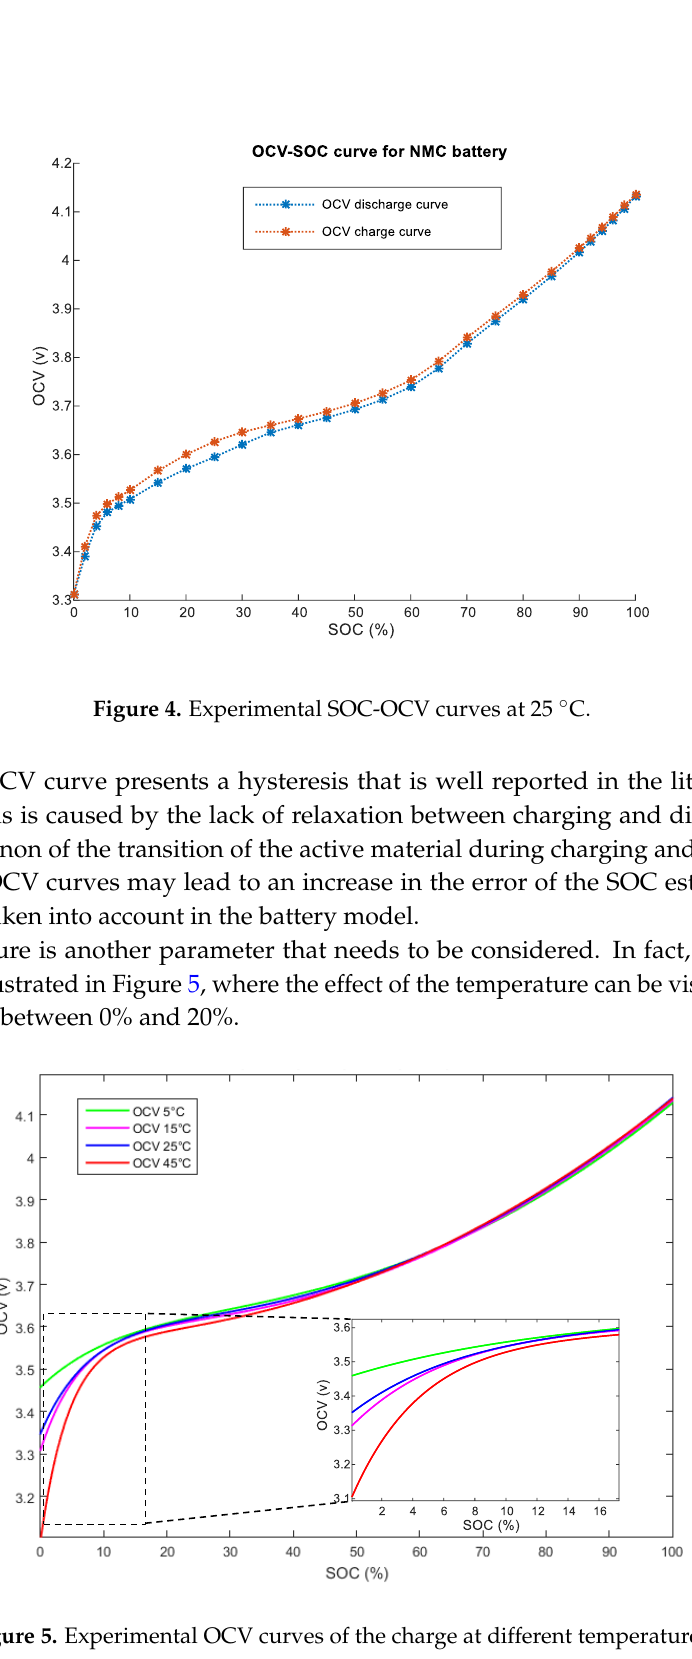
Figure 5. Experimental OCV curves of the charge at different